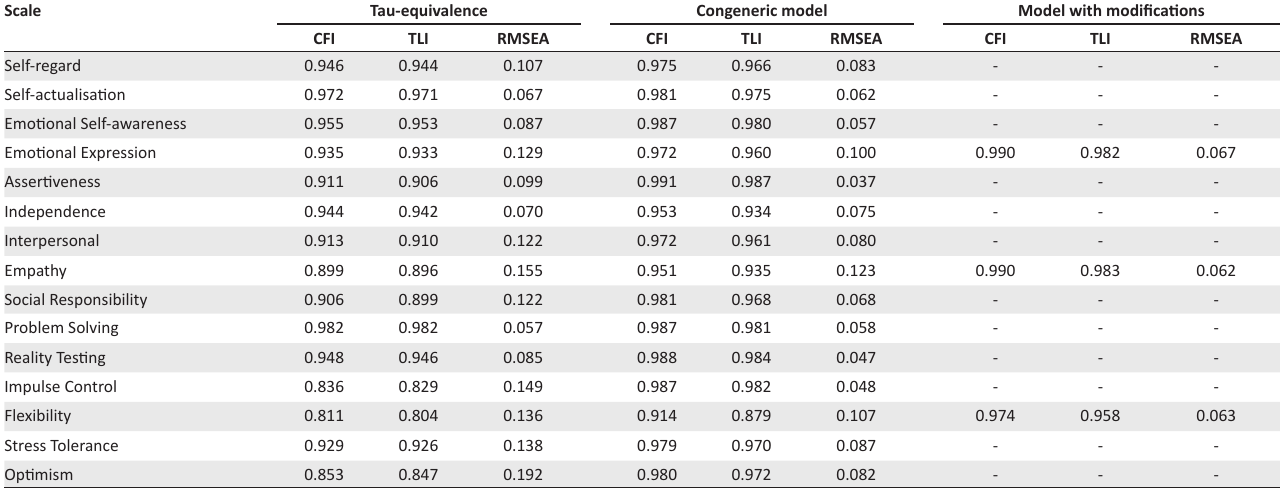
TABLE 2: Fit statistics for the Emotional Quotient Inventory 2.0 subscales.